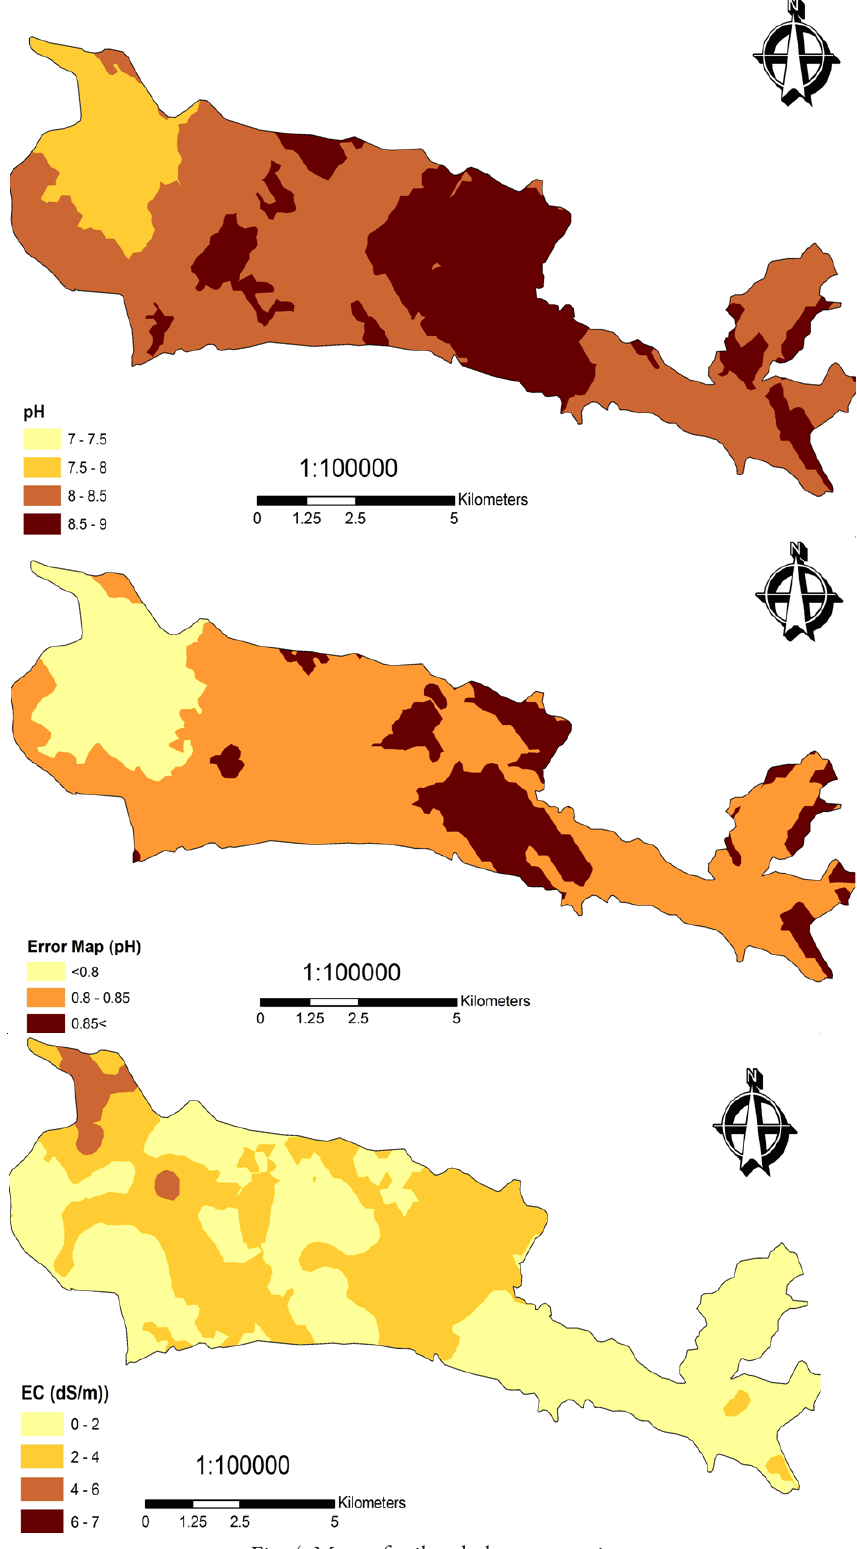
Fig. 4. Maps of soil and plant